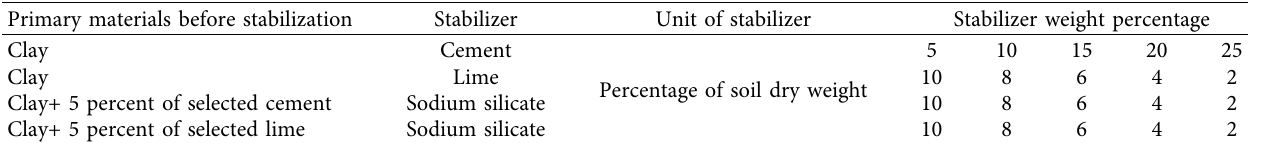
Figure 5: The result of the soil consolidation test in this study. Table 1: Laboratory program of initial soil